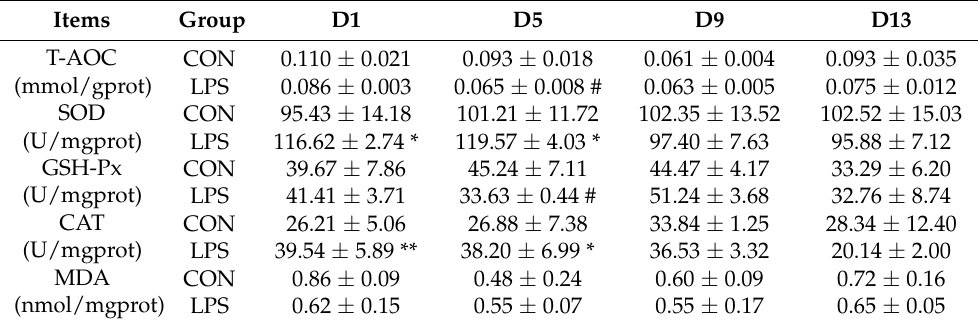
Table 3. Effects of LPS induction on the antioxidant parameters in the livers of weaned